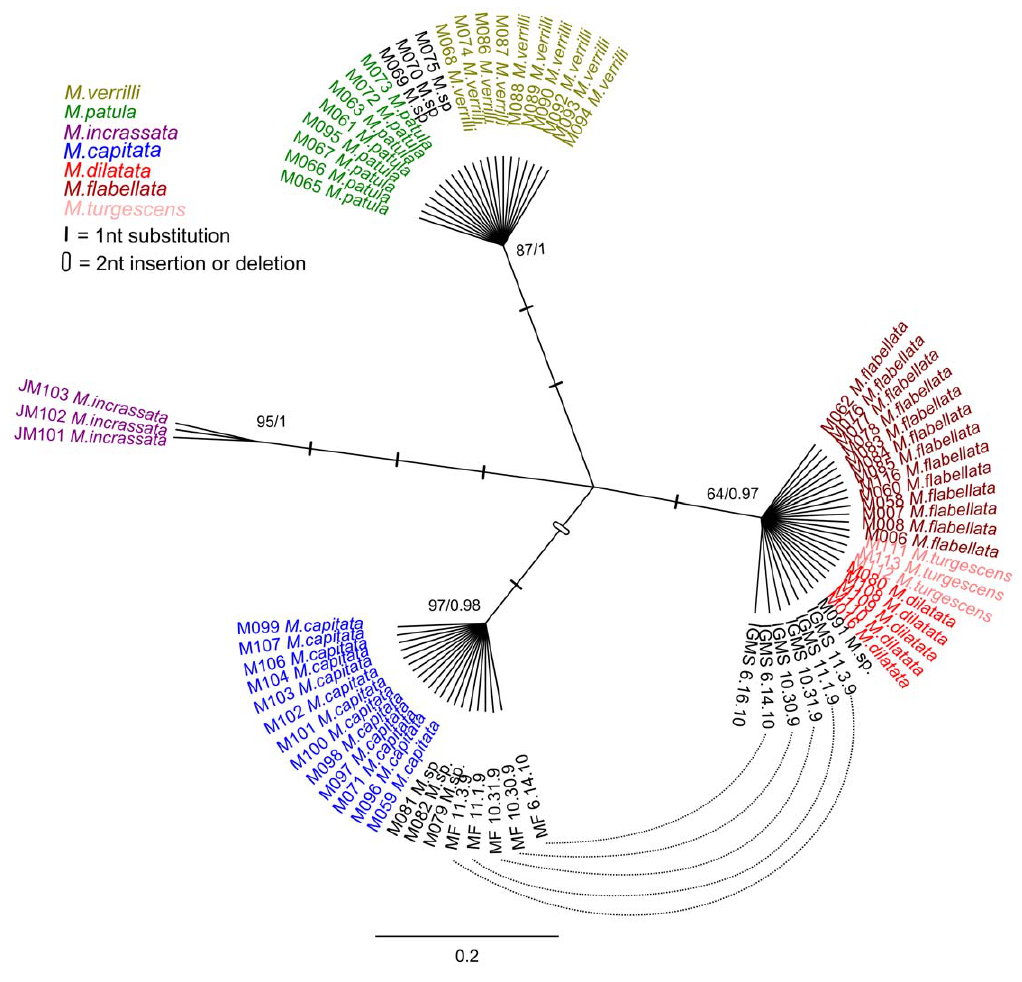
Figure 5. Bayesian inference (BI) tree of the mitochondrial control region for Hawaiian specimens, color-coded by species. Maximum likelihood and BI confidence values are shown. Solid rectangles indicate a single nucleotide substitution, open rectangles indicate a two nucleotide insertion or deletion. Dashed lines indicate mesenterial filaments and invasive gastrovascular multicellular structures (IGMS) tissue types that originated from the same colony.